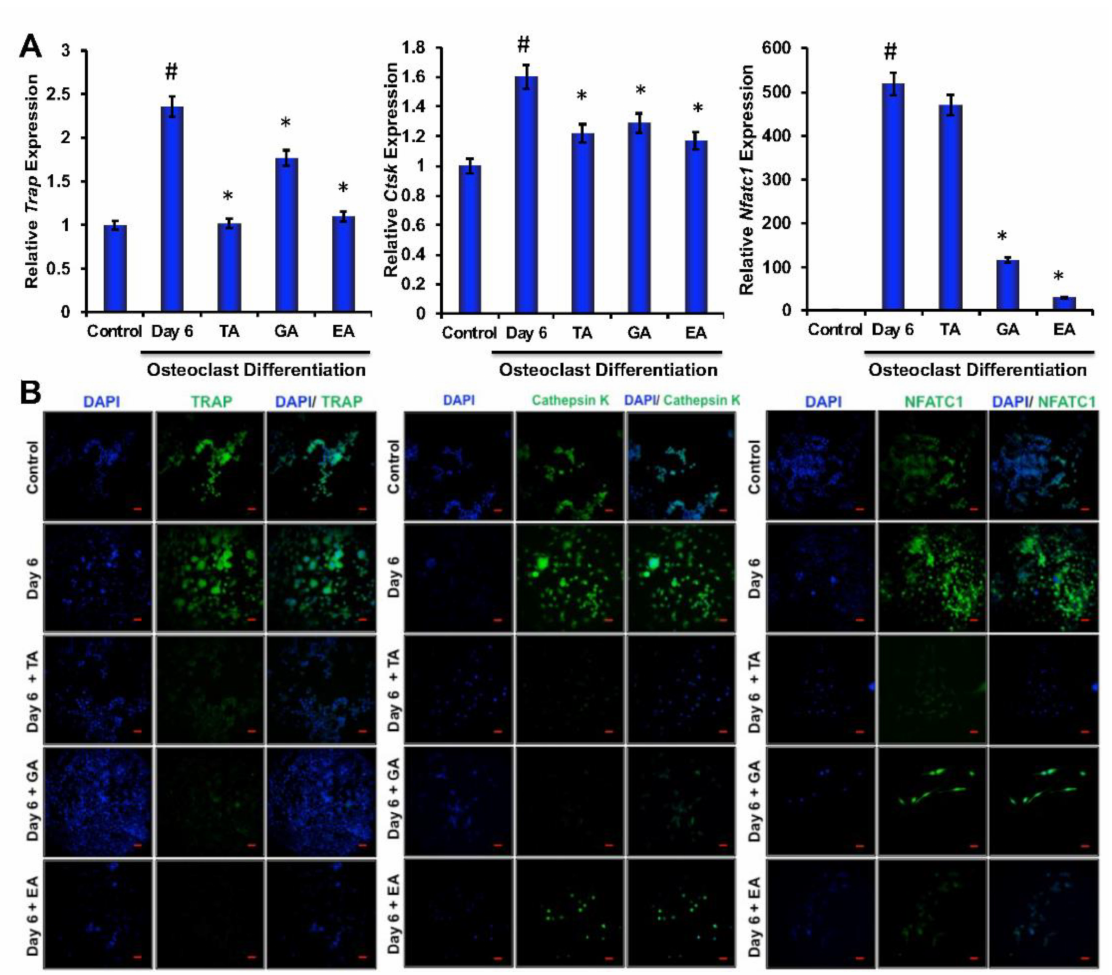
Figure 2. Polyphenolic compounds inhibit osteoclast differentiation-related molecules. ( A ). The quantitative real-time PCR analysis of osteoclast differentiation marker genes such as TRAP, Cathepsin K, and NFATc1 was shown graphically on day 6 in the absence or presence of tannic acid (TA), gallic acid (GA), or ellagic acid (EA) during osteoclast differentiation. (# indicates p < 0.05 when compared between control and day 6 of osteoclast differentiated samples, * indicates p < 0.05, when compared between day 6 of osteoclast differentiated samples in the absence or presence of either of the polyphenolic compounds) ( B ). Immunocytochemically stained images of osteoclast differentiation markers such as TRAP, Cathepsin K, or NFATc1 staining at day 6 in the absence or presence of tannic acid (TA), gallic acid (GA), or ellagic acid (EA) were shown (Scale bar = 20 µ